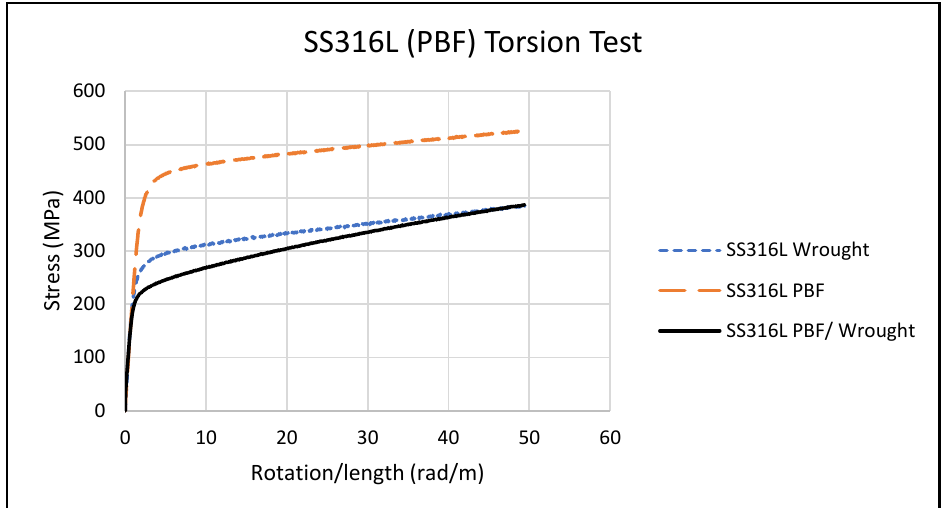
Figure 6. Average torsion test stress/rotation. Table 4. Measured torsion